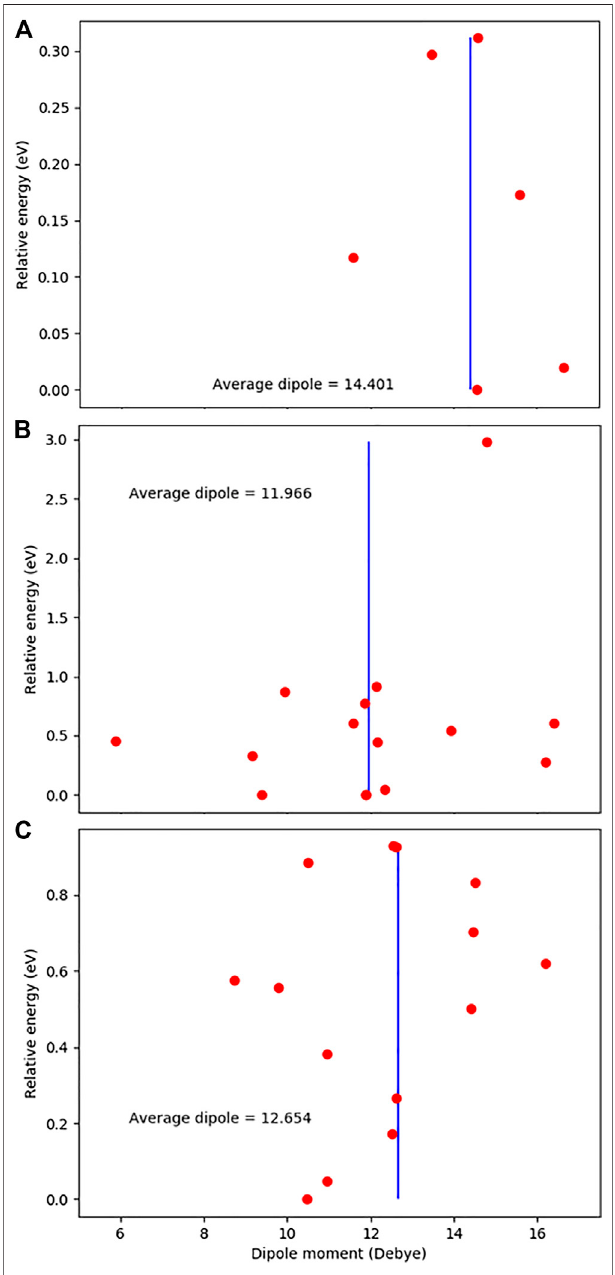
FIGURE 7 | Plot of relative energy vs. dipole moment for molecularly hydrated (MgSiO 3 ) 6 nanosilicates based on the high dipole bare nanosilicate ( Figure 1B ) for (A) one, (B) two, and (C) three water molecules. The vertical blue line denotes the average dipole moment of each